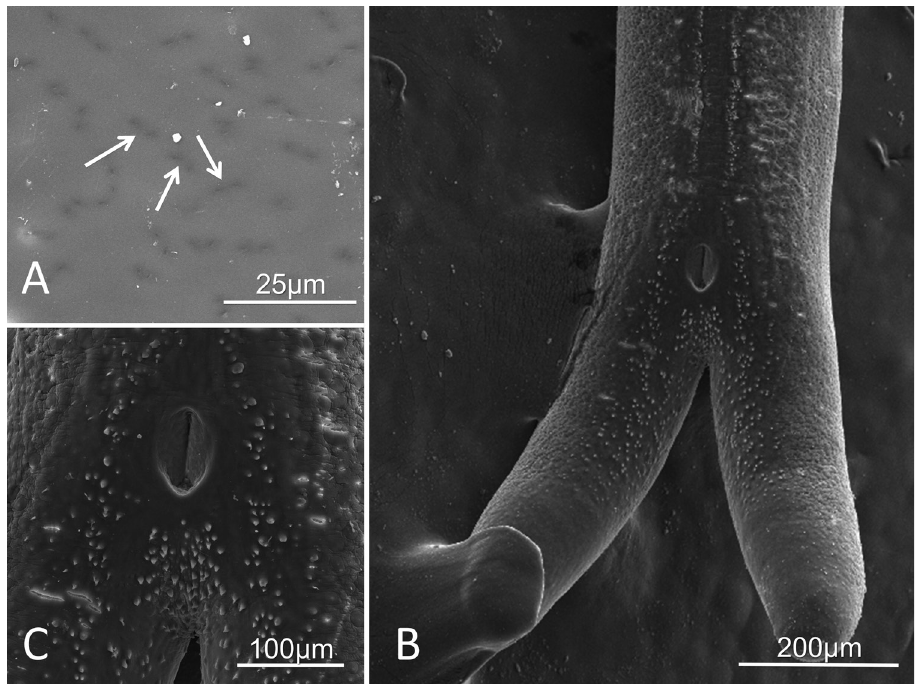
Figure 1. Paragordius amicus sp. n. adult male from the Huachuca Mountains. A Midbody cuticle show- ing lack of obvious surface structure; some superficial structure is seen (arrows) B Bifurcating posterior end exhibiting the characteristic male bifurcating lobes with small, circular pointed lobes extending from the base of the bifurcation up the interior side of the lobes. These mounds are also found on either side as well as below the cloacal opening, eventually merging into the border of the ventral smooth cuticle line. C Cloacal opening, oblong with a straight slit opening extending the length of the opening surrounded by